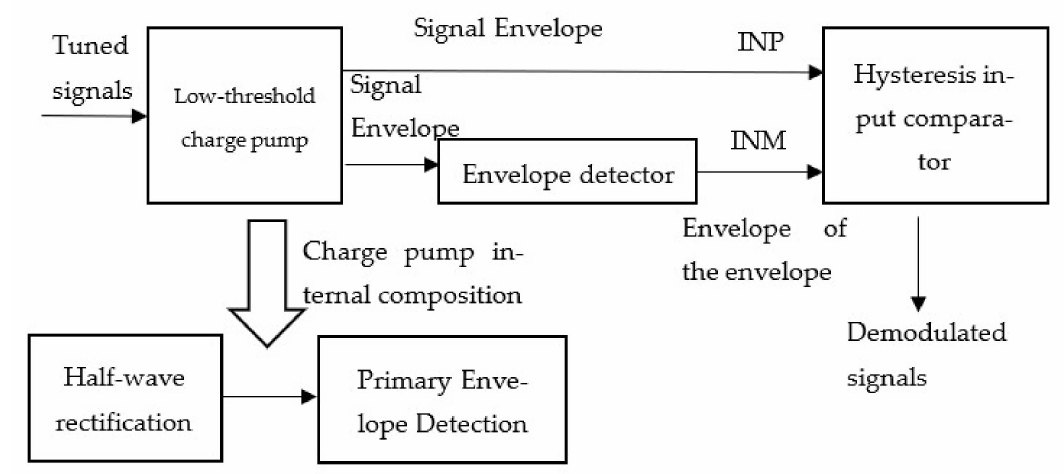
Figure 4. Block diagram of the ASK demodulator.